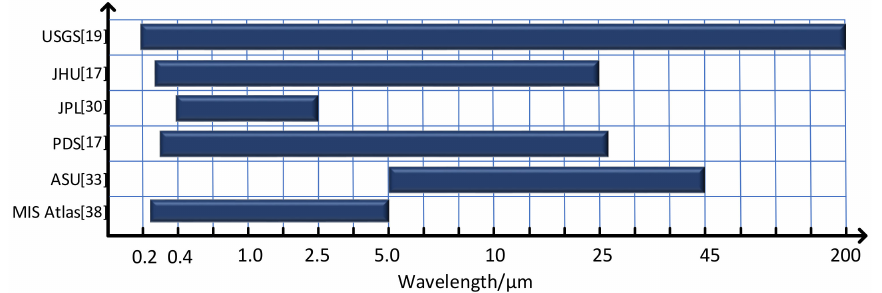
Figure 2. Wavelength range of the shared spectral